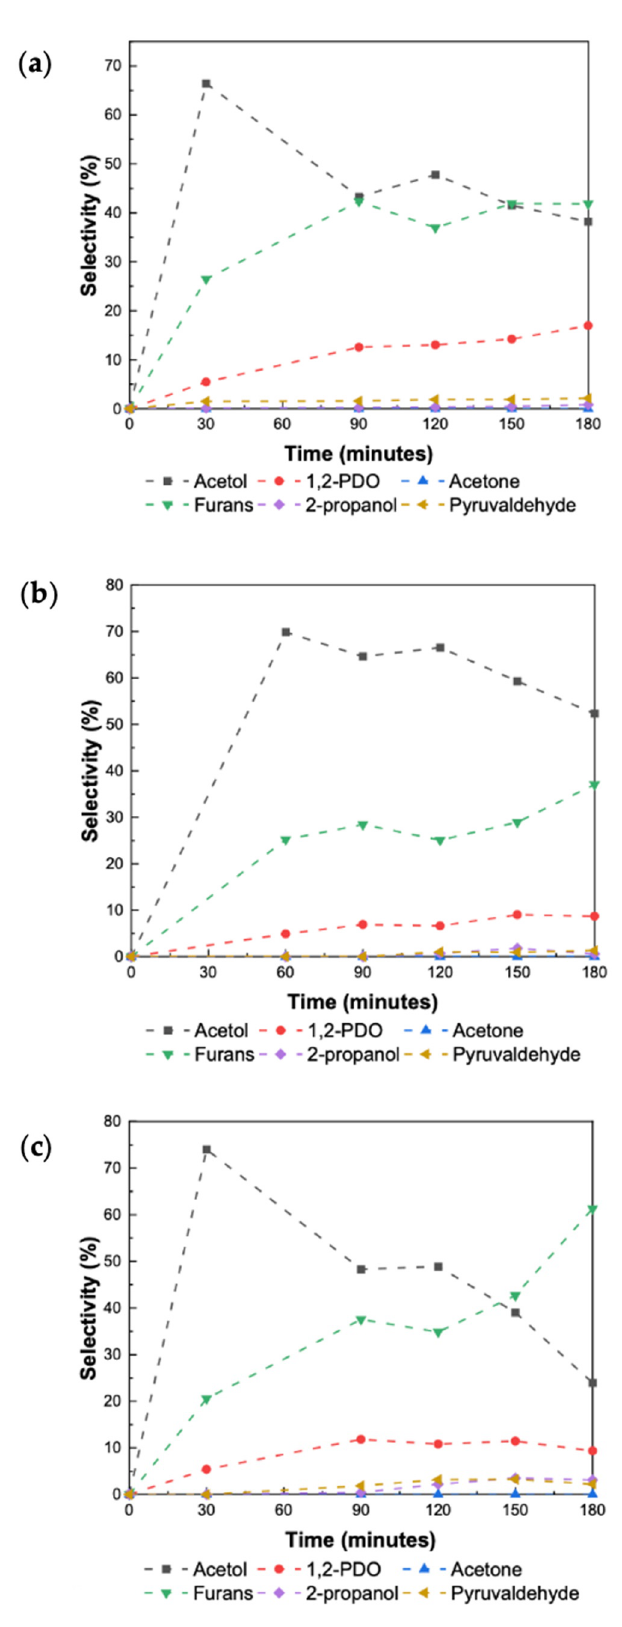
Figure 6. Selectivity of the different products versus time observed for reactions using the copper catalysts: ( a ) Cu NPs/ZrO 2 pH = 4, ( b ) Cu NPs/ZrO 2 pH = 7 and ( c ) Cu NPs/ZrO 2 pH = 9.